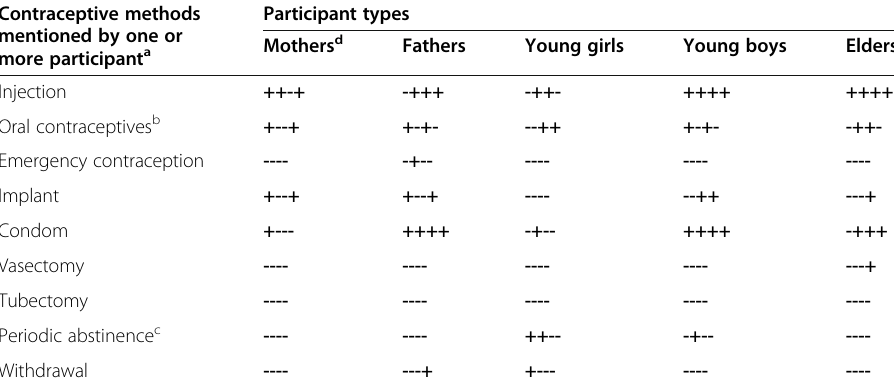
Table 2 Family planning methods discussed by focus group discussion participants Contraceptive methods mentioned by one